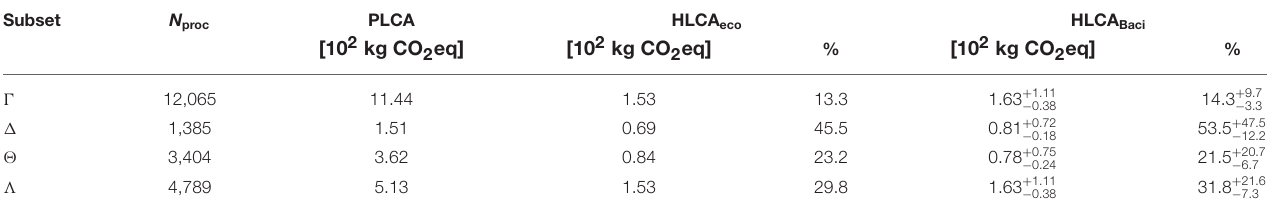
TABLE 5 | As Table 4 , but for the “binary” double counting correction